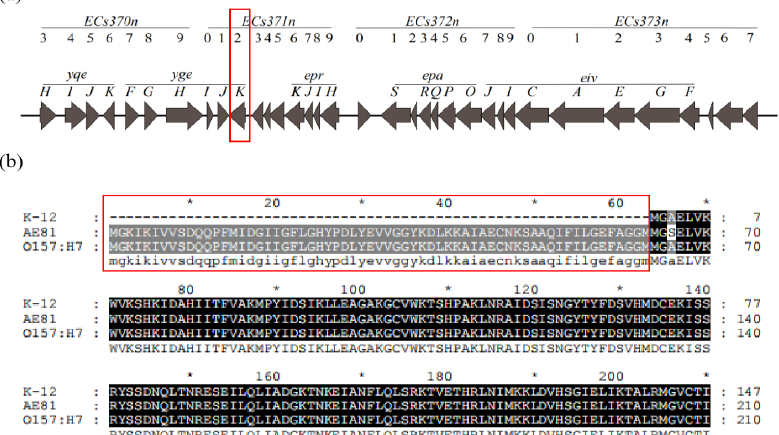
Figure 1. ( a ) ETT2 cluster containing 35 genes from ECs3703 to ECs3737 in AE81; ( b ) alignment analysis of YgeK amino acids in E. coli K12, AE81, and E. coli _O157: H7. Black filled area has the same amino acid, and gray area has different amino acids.